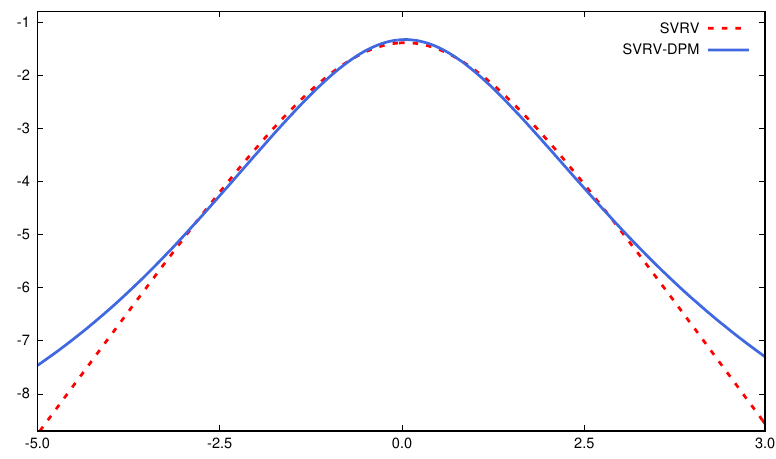
Figure 5. ( Top ): predictive return density p ( r t + 1 | y 1: t ) ; ( Bottom ): log predictive return density log p ( r t + 1 | y 1: t ) of the RSV-DPM and RSV models.